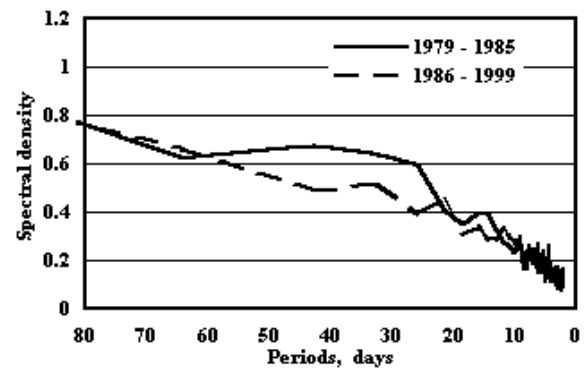
Fig. 3. Mean power spectra of total ozone deviations for the summer season (June–Aug.) and the late fall minimum (Oct.–Nov.) 1979– 2000.